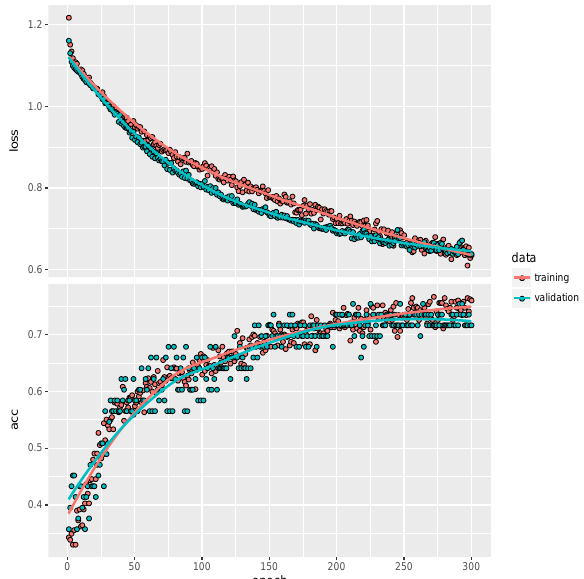
Figure 6. Stochastic gradient descent fitting of the ConvNet given in Listing 2 to the individual trips of the drivers 57, 206 and 238: the upper graph shows the categorical cross-entropy losses; the lower graph shows the correct classification rates for training (red) and validation (blue) data.